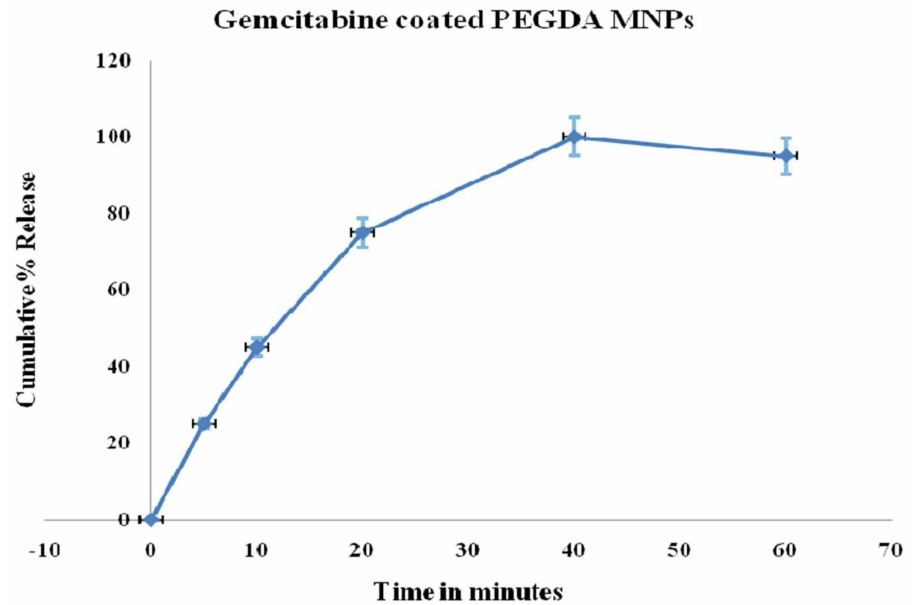
Figure 8. Gemcitabine release profile after coating on microneedles. Release studies were carried out by using Franz diffusion cell. Data presented as mean ± SD, n =